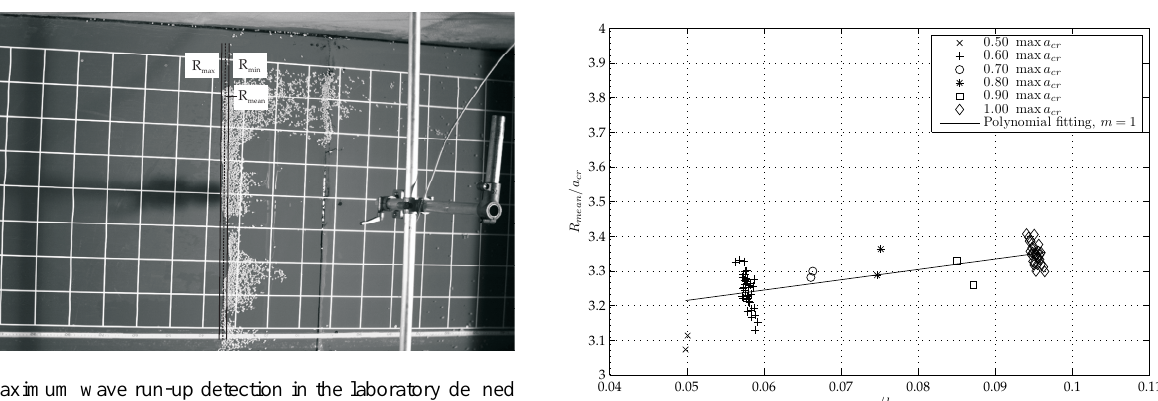
Fig. 7. Maximum wave run-up detection in the laboratory defined as the mean ( R mean ) of the lowest ( R min ) and the highest maximum run-up ( R max ). Fig. 8. Maximum relative run-up as a function of the nonlinearity ( (cid:15) ) of the waves depicted by the markers, a linear polynomial fit de- notes the increase in maximum run-up with increasing nonlinearity. Table 3. Summary of normalized run-up and relative differences with regard to configuration 0 = 1 for MR element rows with n =5;10, listed values base on the polynomial fitting